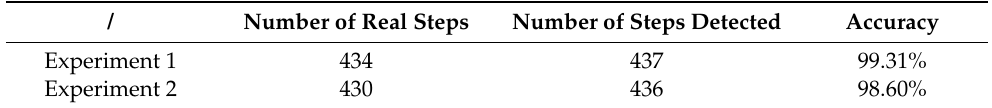
Table 2. Recognition rate of gait segmentation.